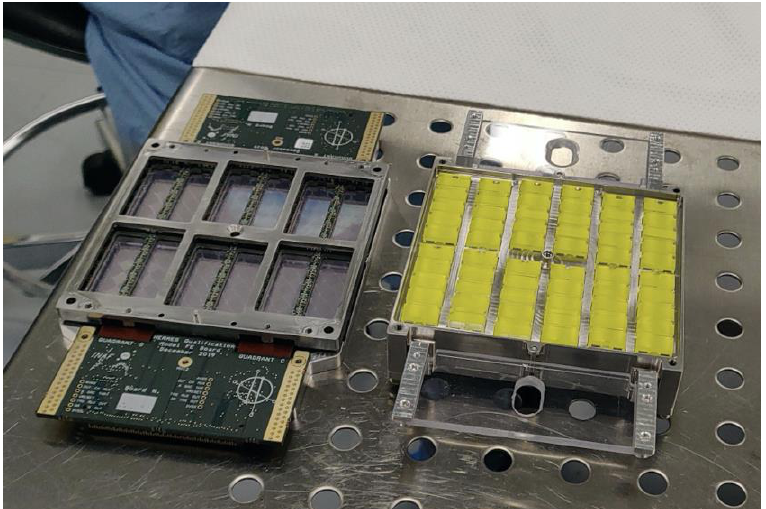
Figure 3. HERMES pathfinder detector system during integration at Fondazione Bruno Kessler la- boratories in Trento, Italy. laboratories in Trento,